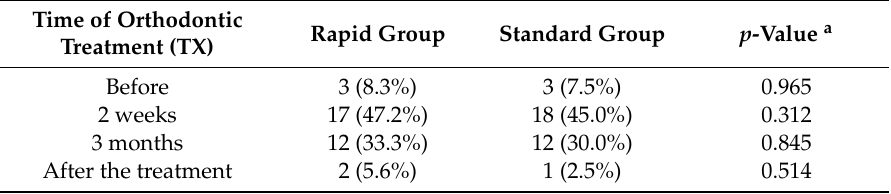
Table 7. OHIP-14 Simple Count—the number of patients with oral health impacts reported as occasionally or more